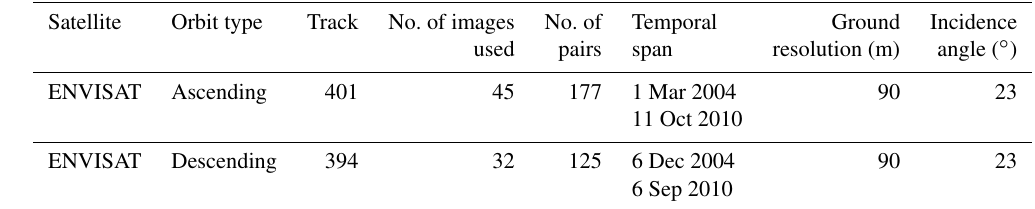
Table 1. ENVISAT dataset. Ground resolution values are obtained after a multi-looking operation. Satellite Orbit type Track No. of images No. of Temporal Ground Incidence used pairs span resolution (m) angle ( ◦ ) ENVISAT Ascending 401 45 177 1 Mar 2004 90 23 11 Oct 2010 ENVISAT Descending 394 32 125 6 Dec 2004 90 23 6 Sep